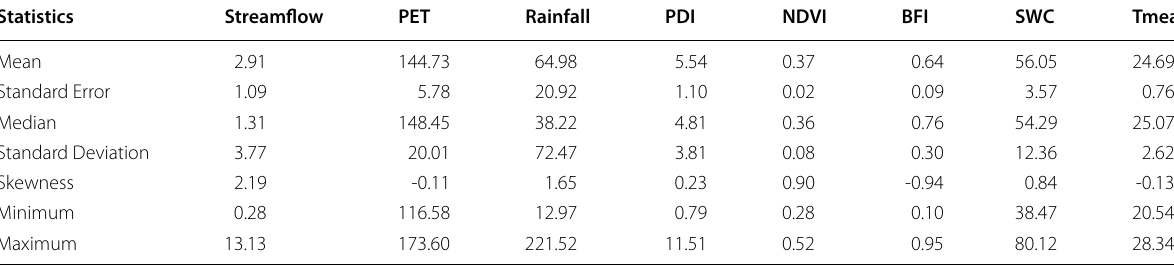
NB: PET Potential Evapotranspiration (mm), NDVI = (mm), Rainfall (mm), Tmean